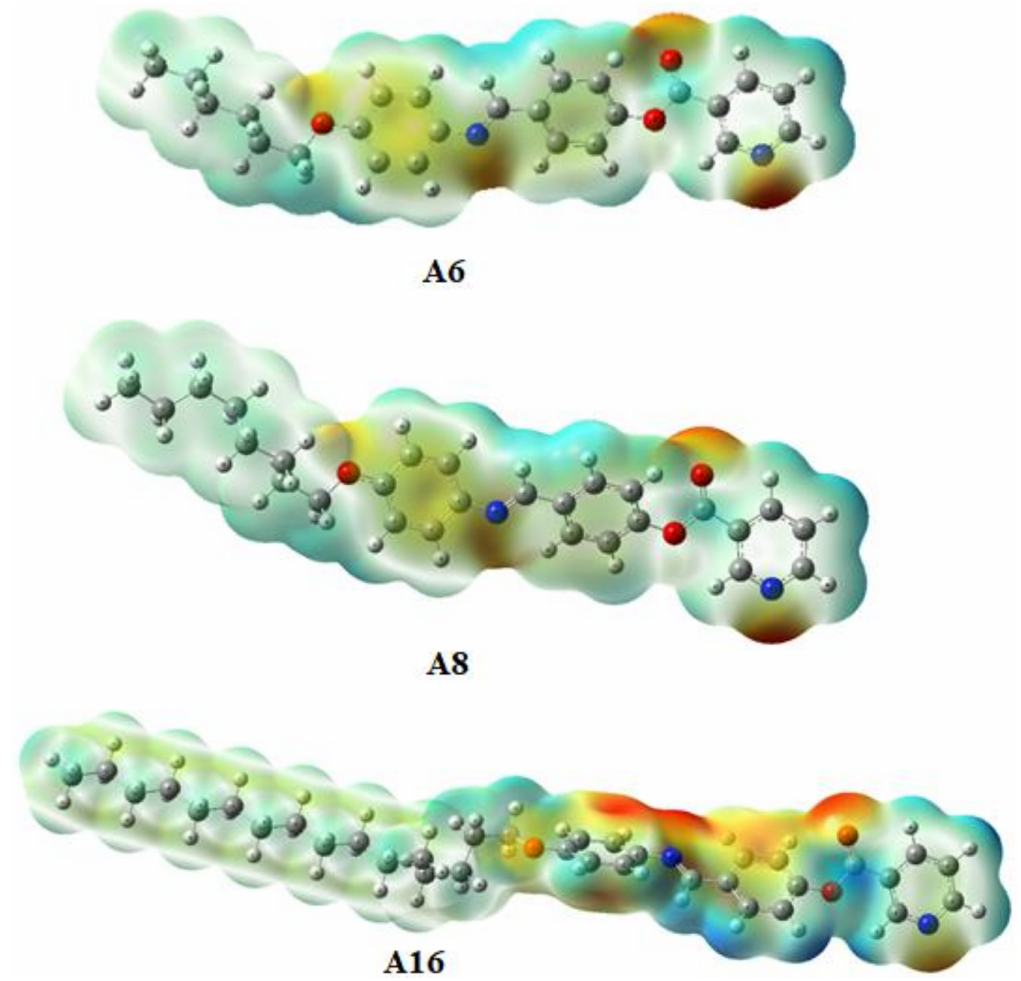
Figure 6. Molecular electrostatic potentials (MEPs) of the investigated group, An